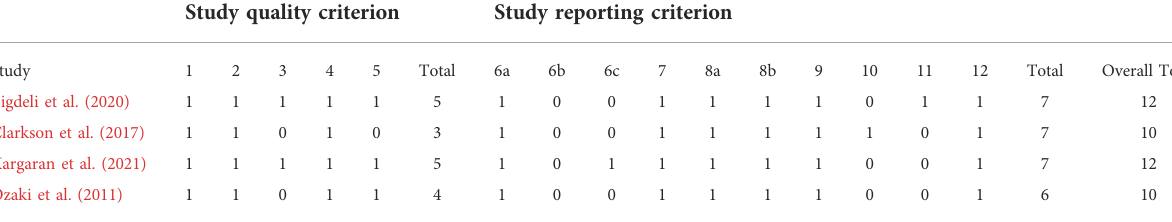
TABLE 3 TESTEX assessment of the quality and reporting of included randomized controlled